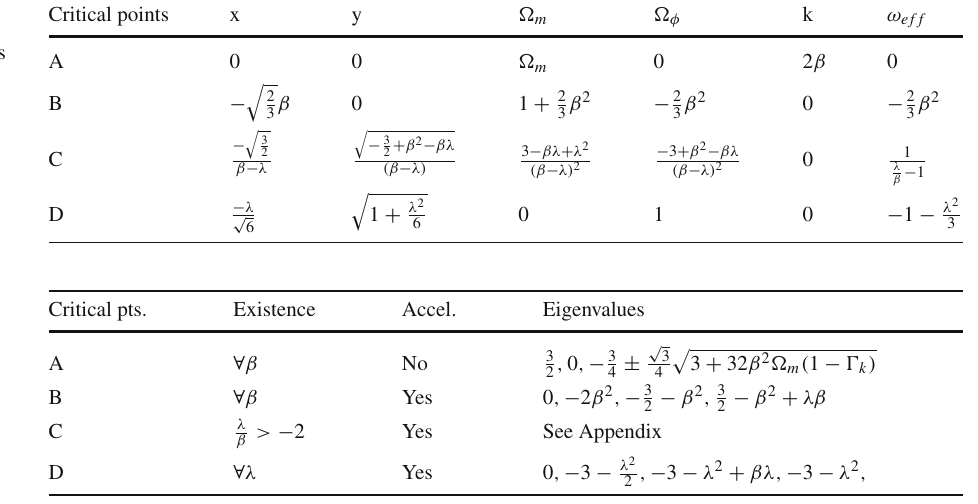
Critical points